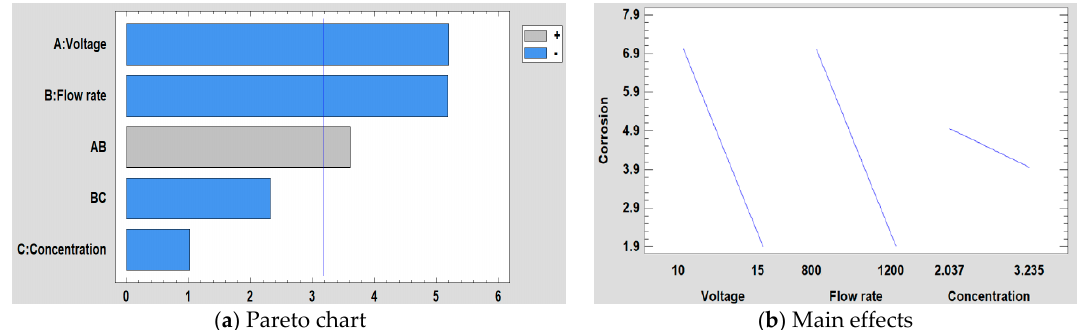
Figure 15. ( a ) Pareto chart and ( b ) the main effects on corrosion resistance.